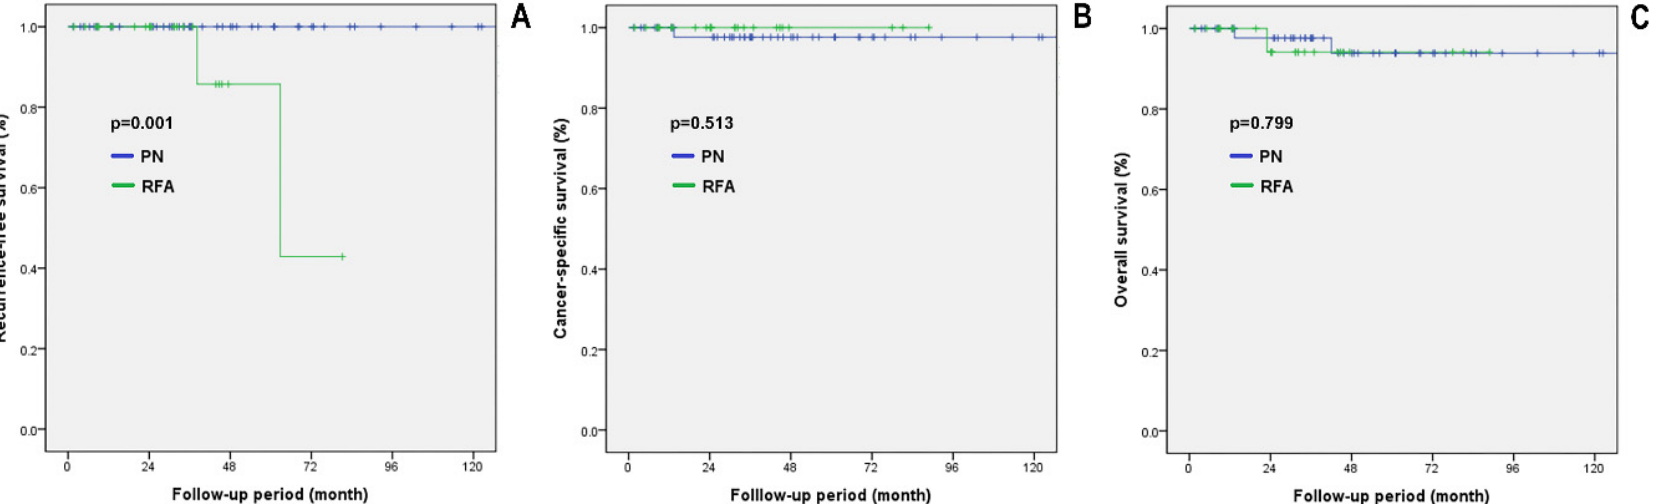
Figure 4. Survival analysis in propensity score matched cohorts with CKD stage 3 or higher. ( A ) RFS, recurrence-free survival; ( B ) CSS, cancer-specific survival; ( C ) OS, overall survival. PN: partial nephrectomy; RFA: radiofrequency ablation.